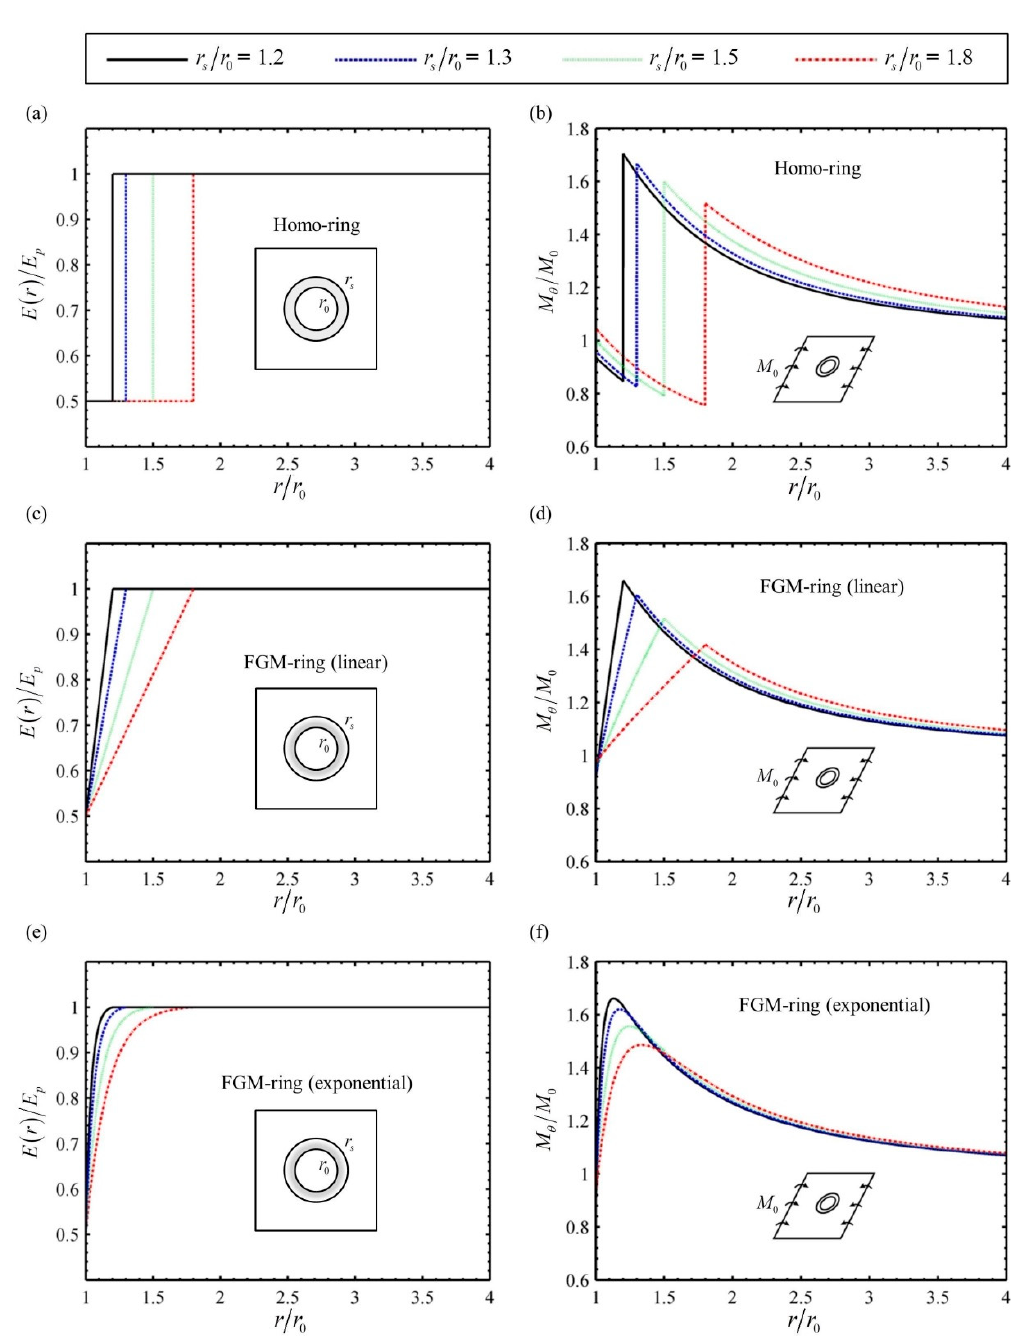
Figure 7. Distribution of moments M θ / M 0 along the radial direction ( θ = ± 90 0 ) for di ff erent widths of ring: ( a ) variation of Young’s modulus for homogeneous ring; ( b ) distribution of moments for homogeneous ring; ( c ) variation of Young’s modulus for linear FGM ring; ( d ) distribution of moments for linear FGM ring; ( e ) variation of Young’s modulus for exponential FGM ring; ( f ) distribution of moments for exponential FGM ring.